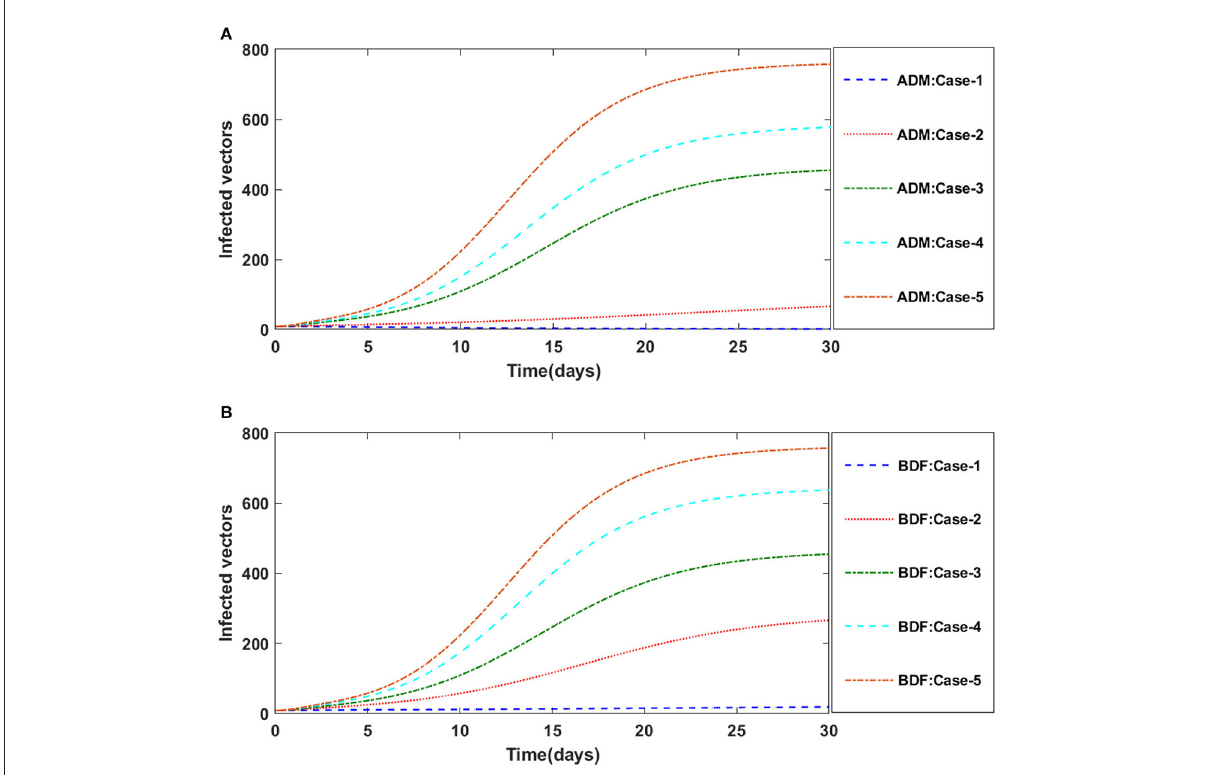
FIGURE21 (A) Dynamics of infected vectors for the varition in (cid:127) using ADM for model B1. (B) Dynamics of infected vectors for the varition in (cid:127) using BDF for model B1.